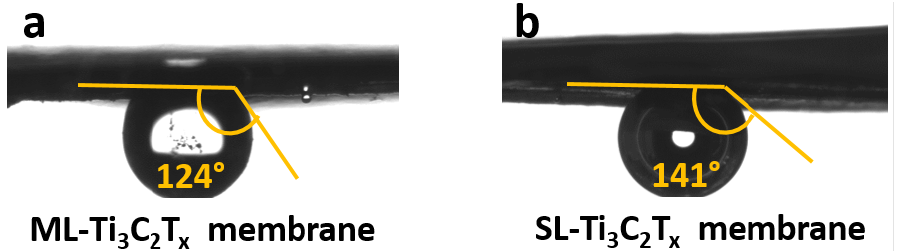
Figure 7. Underwater contact angle of vegetable oil on ( a ) ML-Ti 3 C 2 T x and ( b ) SL-Ti 3 C 2 T x membranes.